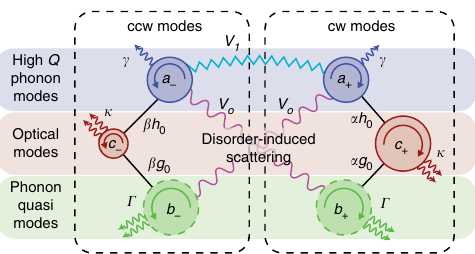
Fig. 3 Model for coupling between the anti-Stokes (higher frequency) optical modes c ± , high- Q phonon modes a ± , and phonon quasi-modes b ± in cw and ccw directions. Light couples to the a ± and b ± phonons with different optomechanical interaction strength. Disorder-induced scattering between a ± phonons and the b ∓ quasi-mode occurs with strength V 0 , and between a ± and a ∓ high- Q phonons occurs with strength V 1 . Our experimental case features V 1 (cid:4) V 0 . Details on individual parameters are provided in the